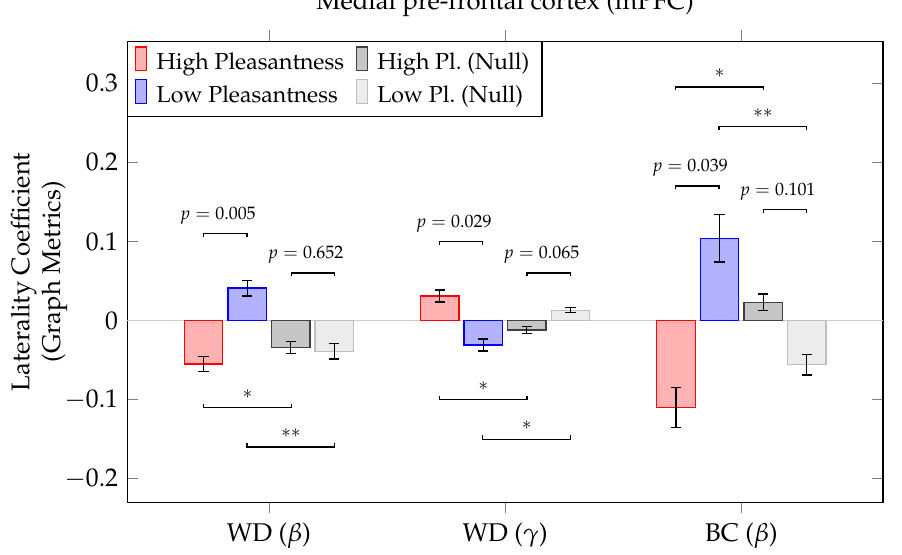
Figure 7. Statistically significant differences in laterality coefficients between high- and low pleasant- ness stimuli (individual regions, paired samples t-tests), including results of graph null-hypothesis testing (*: p < 0.05, **: p < 0.01). Coefficients were computed based on graph metrics; positive coefficients indicate a left-dominant response, right-dominance is indicated by negative coefficients. FDR corrected p -values are depicted; error bars show the standard error.